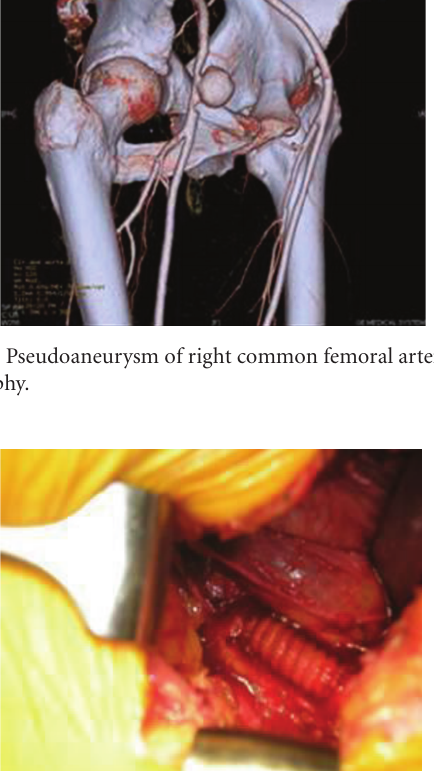
Laboratory results showed leucocytosis (16 × 109/L) and elevation of C-reactive protein to 130 mg/l. Hemocultures that were obtained were negative. Ultrasonography and CT angiography verified presence of pseudoaneurysm of right common femoral artery (2.5 cm in diameter) (Figure